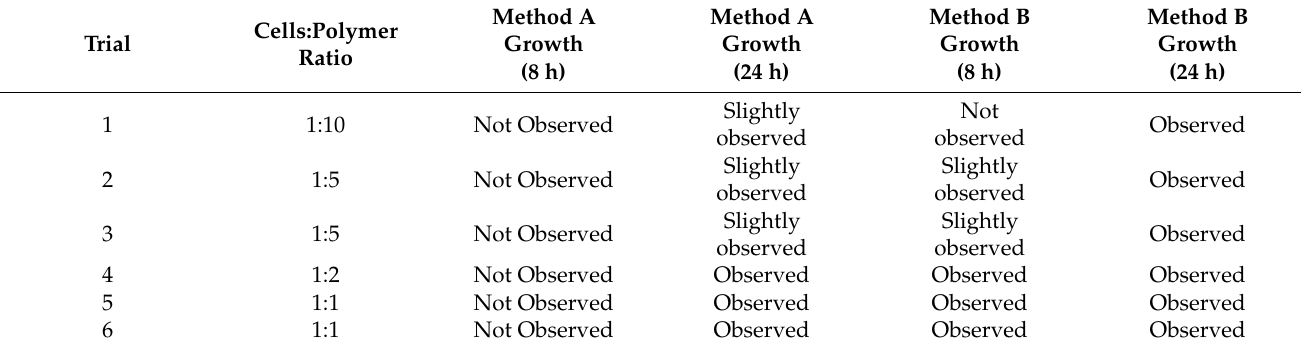
Table 3. Results of the cell growth after 8 h and 24 h according to methods A and B.